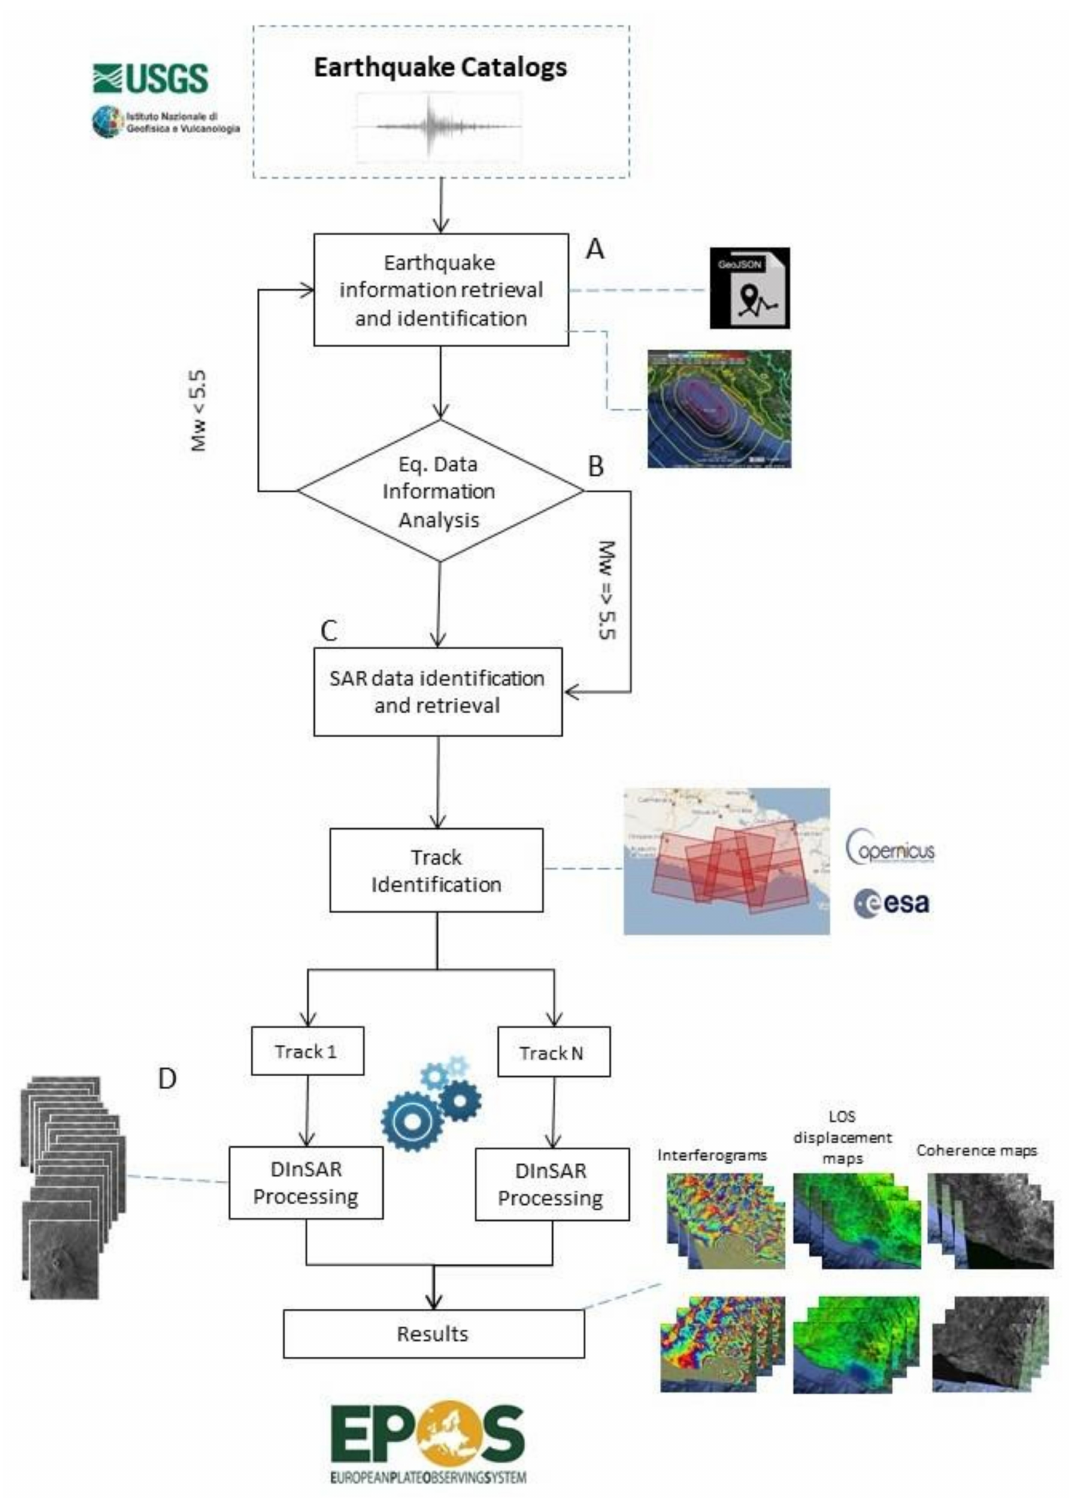
Figure 1. Workflow of the implemented tool for the automatic and unsupervised generation of coseismic di ff erential synthetic aperture radar interferometry (DInSAR) products (interferograms, displacement maps, and coherence maps) from Sentinel-1